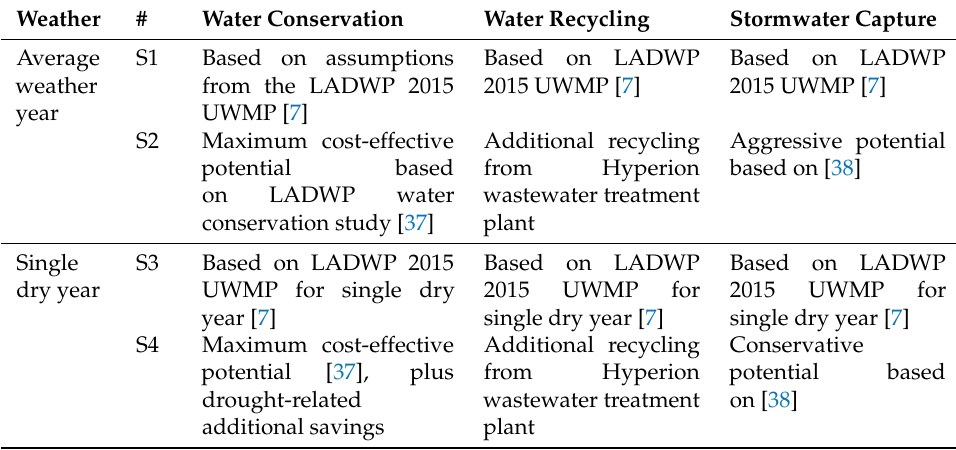
Table 2. Description of scenarios analyzed in this